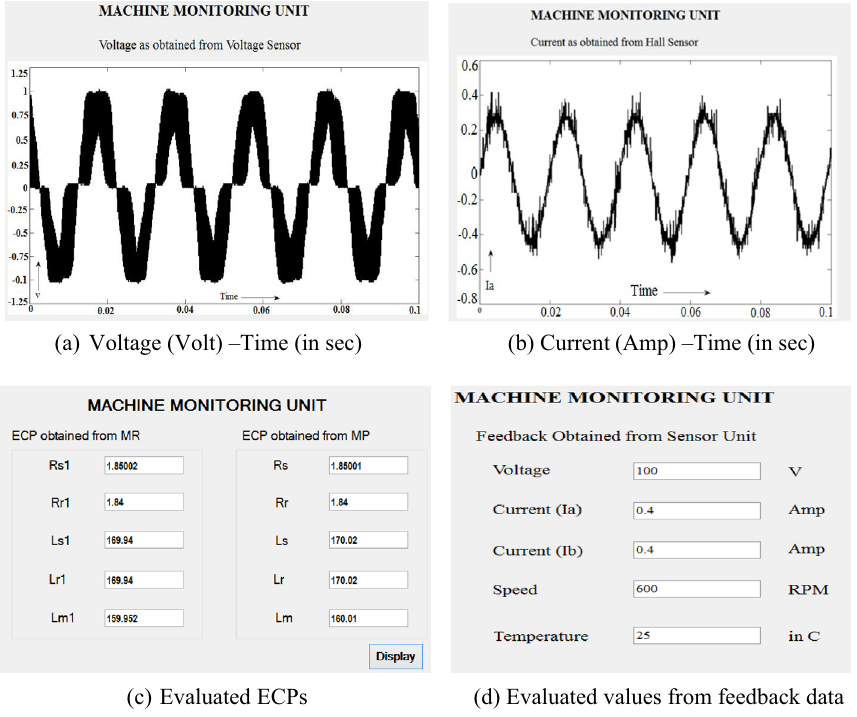
Fig. 19 Waveforms of sensor data for a voltage, b current, c evaluated ECPs and d evaluated values from feedback data as communicated to MMU